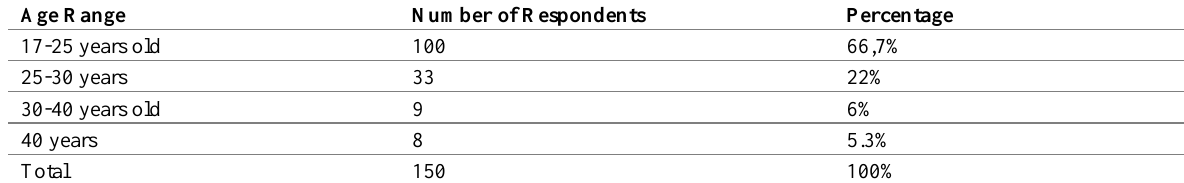
Table 5 : Characteristics of Respondents by Age